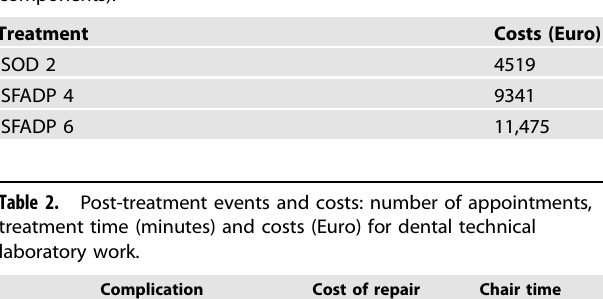
Comparison between all three groups together: p < 0.001 (Kruskall- Wallis test). SD standard